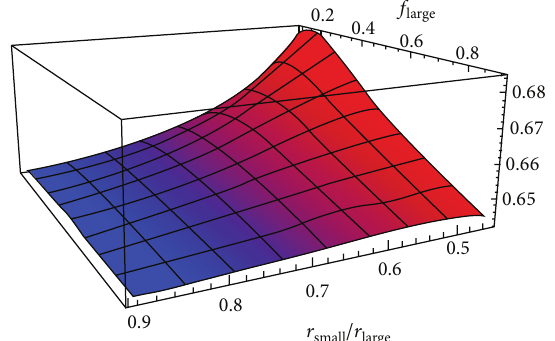
Figure 3: Construction scheme of the cherry-pit model. Circles Figure 2: Volume fraction of systems of dense-random packed (solid lines) mark the pits, gray regions are the spheres which /𝑟 sphereswithbimodaldistributionofradiiversussizeratio 𝑟 partially overlap, and the solid material is small large of spheres and number fraction 𝑓 of large spheres. large